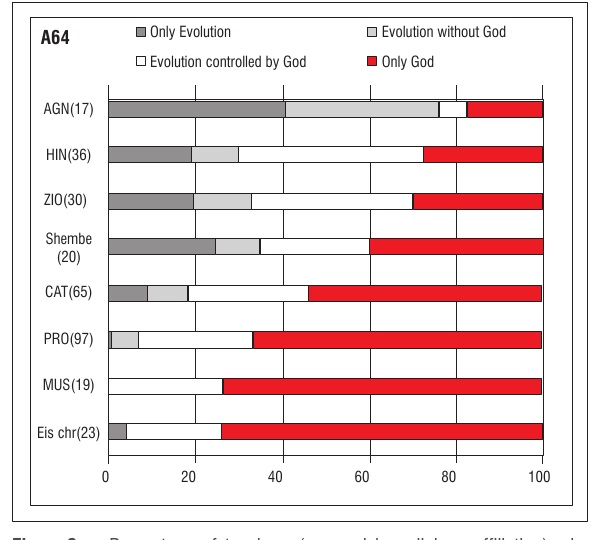
Figure 3: Percentage of teachers (grouped by religious affiliation) who selected creationist (red), evolutionist (black and grey), or mixed creationist and evolutionist (white) answers to question A64 on the origin of